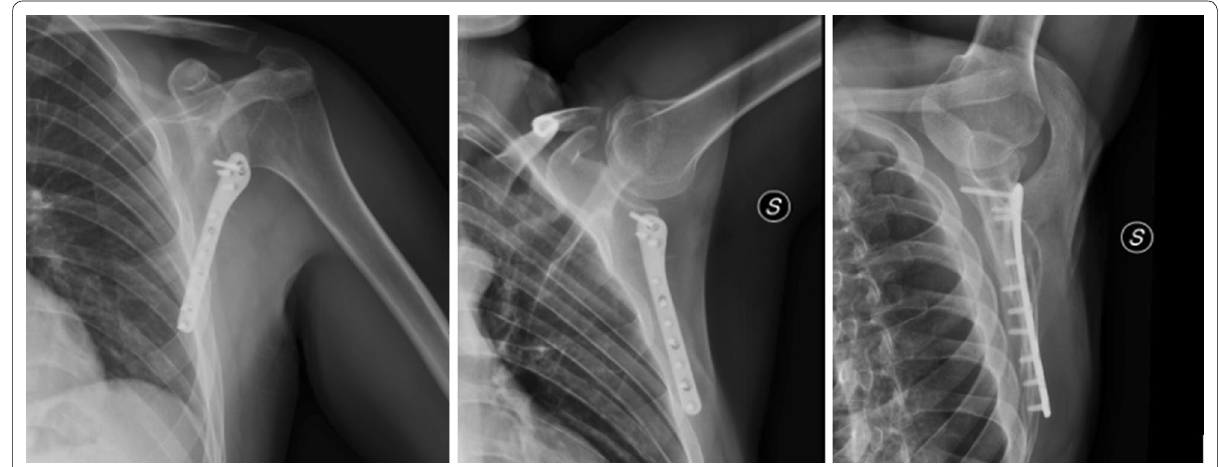
Fig. 2 Lateral border plate (X-ray 2 years after